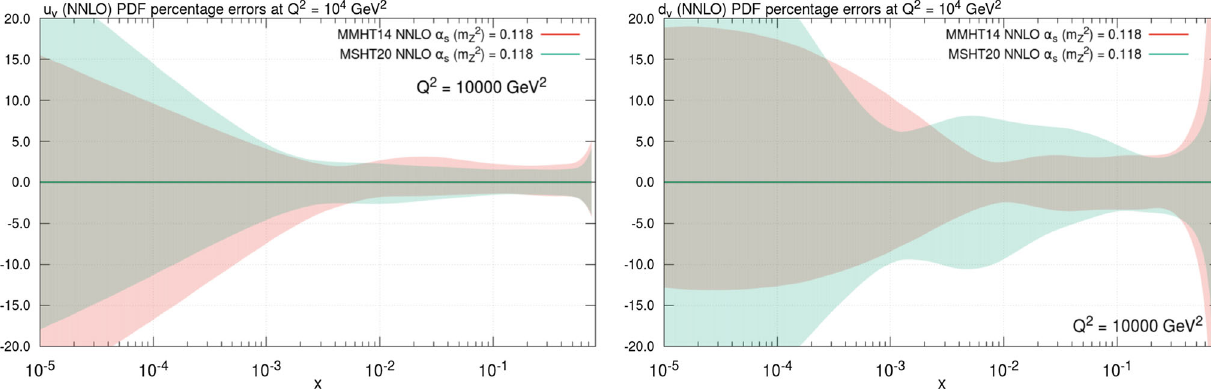
Fig. 23 Percentage uncertainties of (left) Up valence and (right) Down valence PDFs for MSHT20 and MMHT14 at NNLO and Q 2 = 10 4 GeV 2